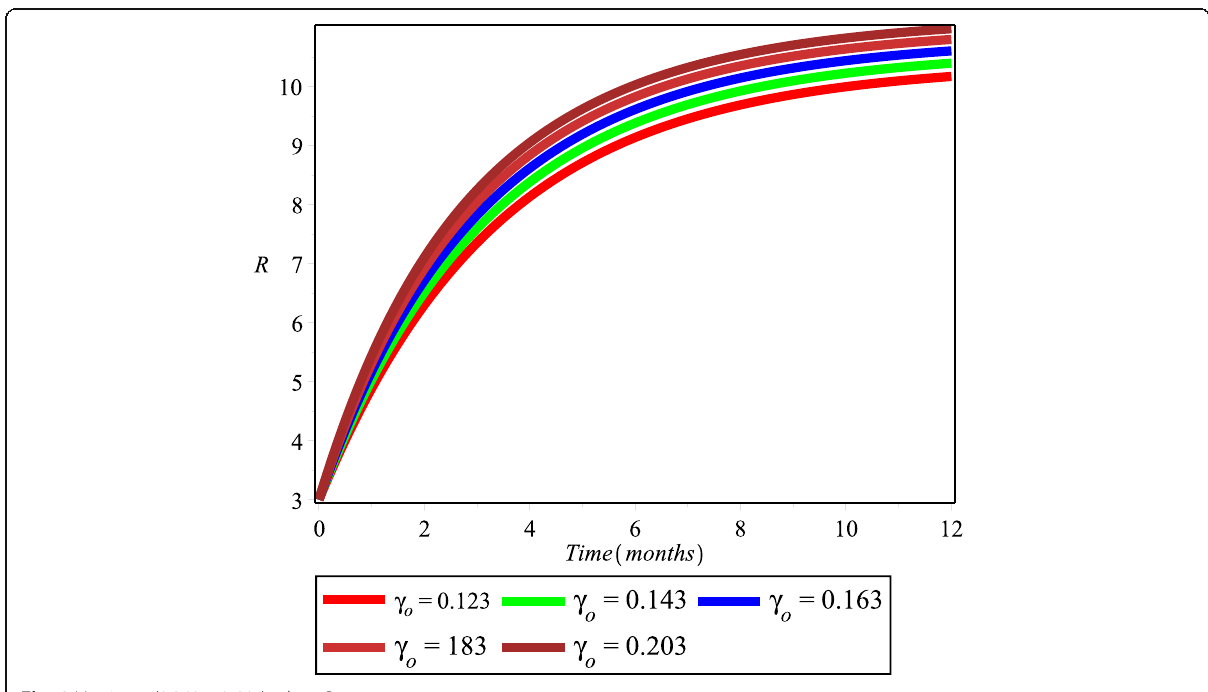
Fig. 8 Varying ϵ (0.260 − 0.661) when R r > 1